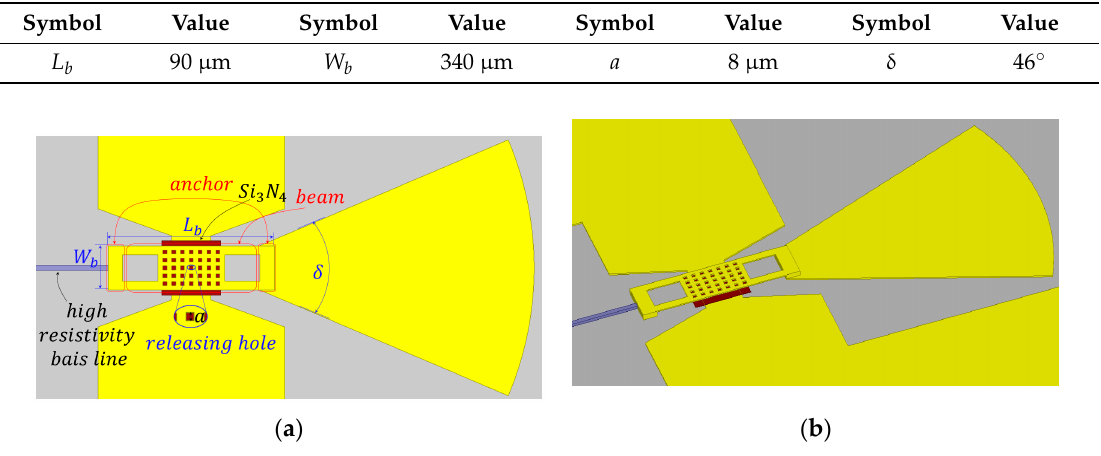
Figure 2. Designed RF MEMS switch. ( a ) Top view. ( b ) 3D view.